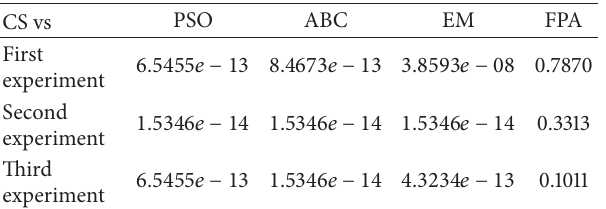
Table 5: 𝑃 -values produced by Wilcoxon’s test comparing CS vs PSO, ABC, EM and FPA over the “The average 𝑓(𝜃) values (AV)” from Tables 1, 2 and